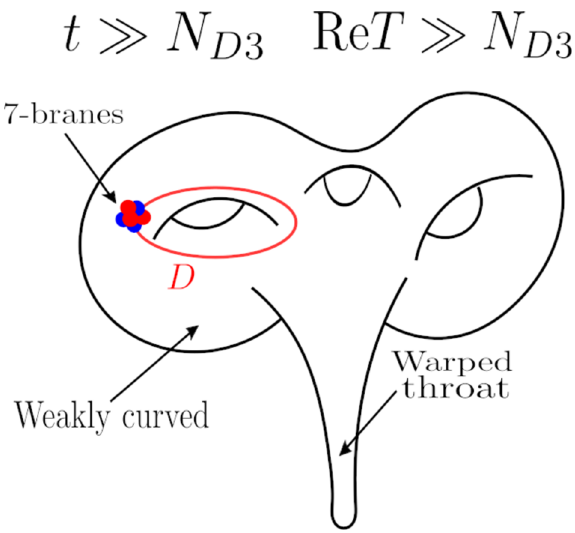
Figure 17 . Compact CY with warped throat, seven-branes contributing the D3 tadpole and transversally intersecting rigid divisor D supporting an ED3 instanton responsible for moduli sta- bilization. We depict the large volume regime where the D7-branes can be treated semi-classically, i.e. they are all stacked on top of each other. The bulk CY is weakly curved everywhere except exponentially close to the